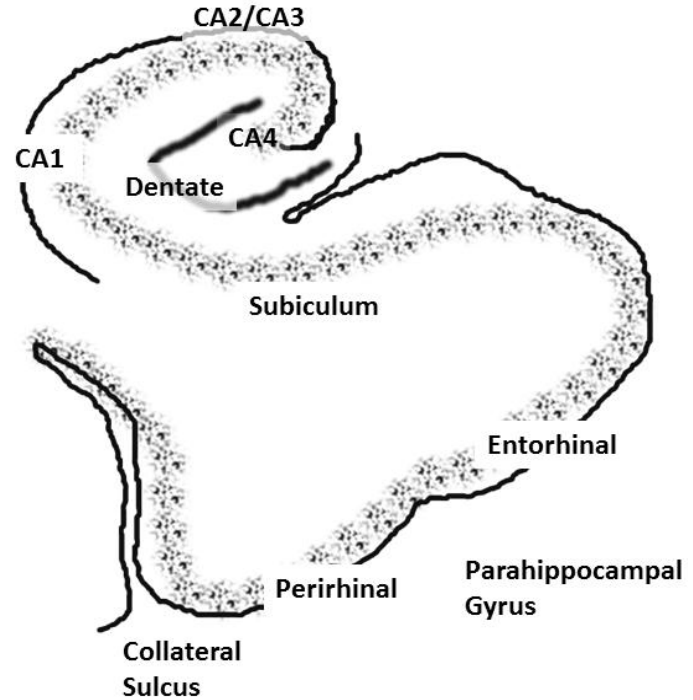
Figure 1. A coronal slice showing the hippocampus and associated structures, including the cornu ammonis, or CA, layers, the dentate gyrus and the subiculum. The entorhinal and perirhinal areas are included in the parahippocampal